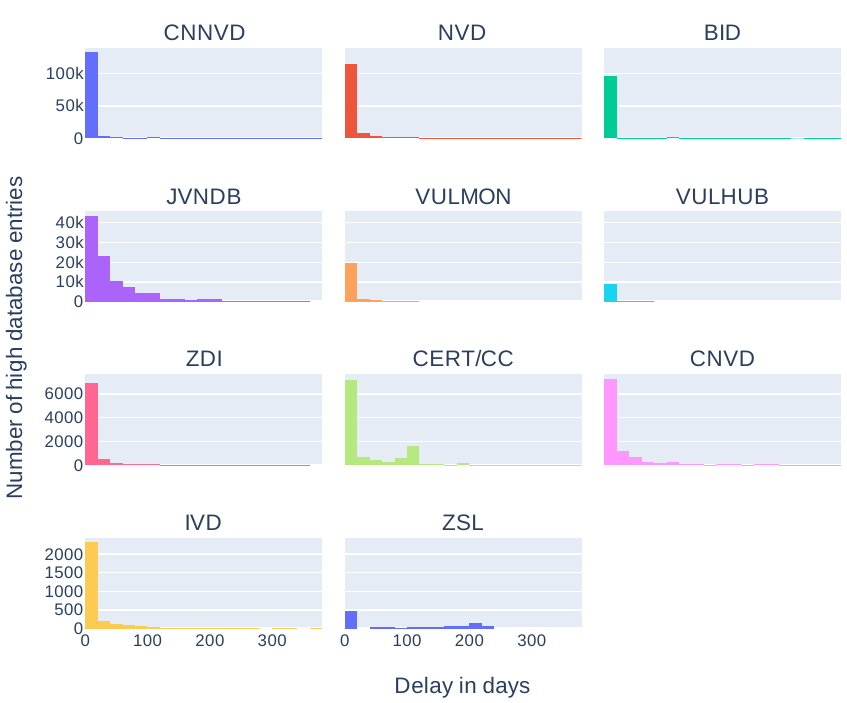
Figure 7. Histograms of number of entries in the high database with given delay (in days, since first publish date) in publishing vulnerability information per source.